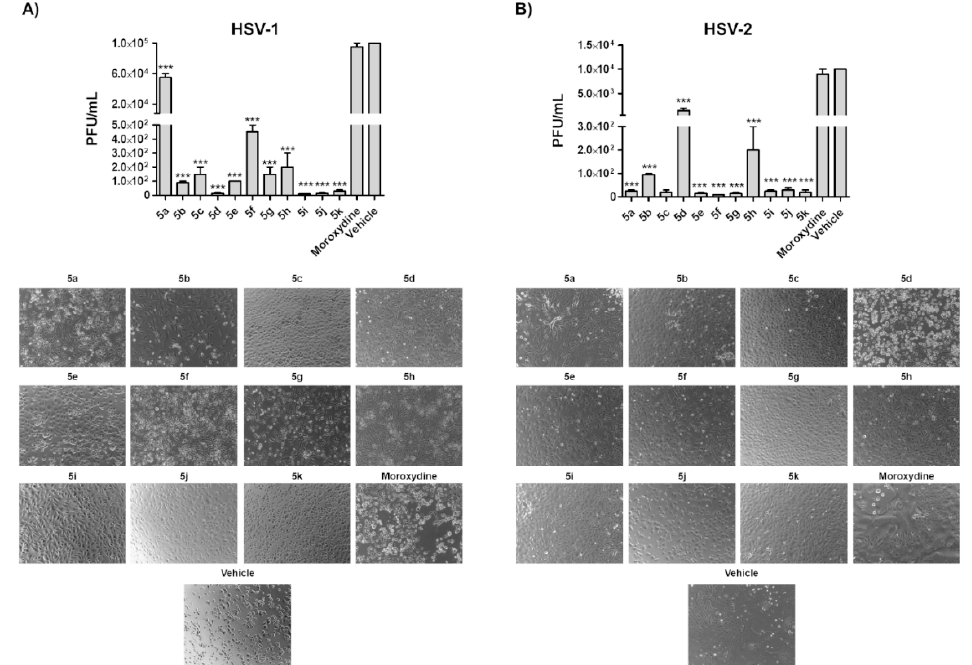
Figure 3. Antiviral activity of 5a – k against HSV-1 and HSV-2. Upper panel. Virus yield reduction assay. Vero cells were treated as described in the manuscript with the indicated compounds. The extent of ( A ) HSV-1 and ( B ) HSV-2 replication was then assessed by titrating the infectivity of supernatants and cell-associated viruses using a standard plaque assay in Vero cells. Plaques were microscopically counted, and the mean plaque counts for each molecule were expressed as PFU/mL. Mean ± SEM is shown (***, p < 0.001, one-way ANOVA followed by Bonferroni’s post-tests). Lower panel. Representative light microscopy images of Vero cells infected with ( A ) HSV-1 or ( B ) HSV-2 and treated with the indicated compounds, as described for virus yield reduction assay. Original magnification: 20×.